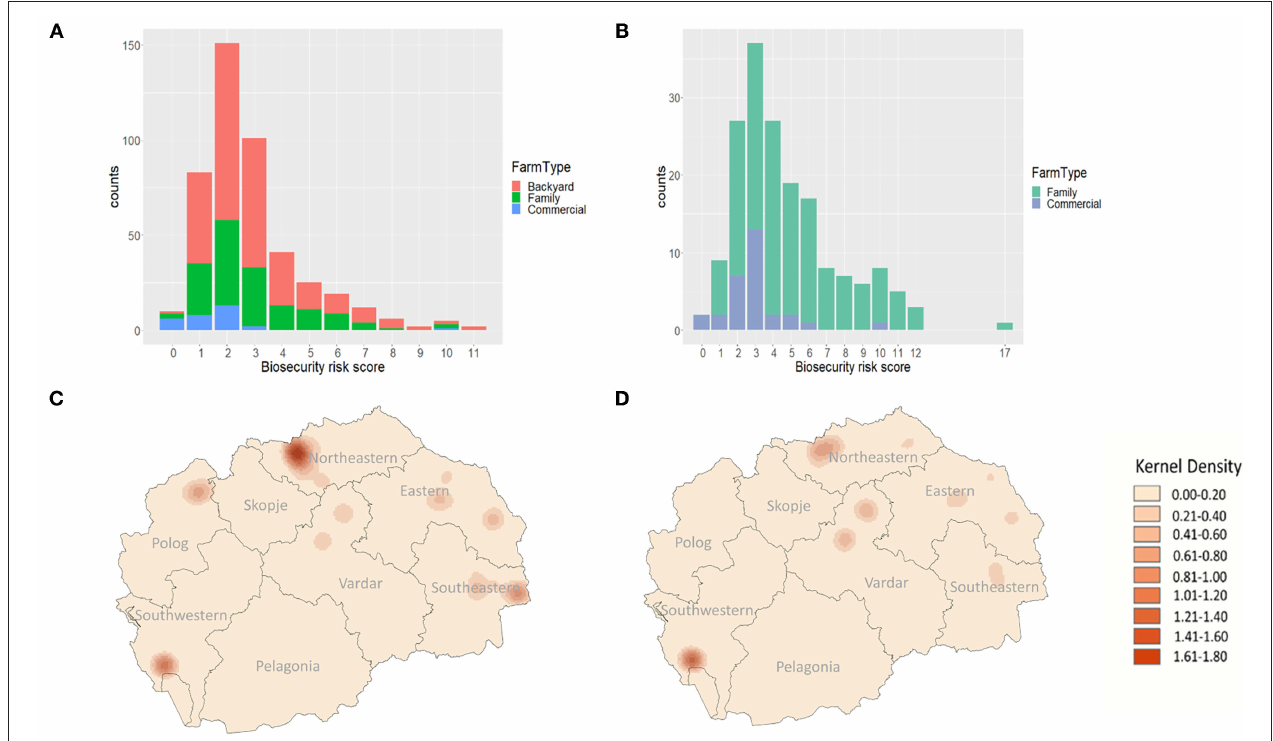
FIGURE 6 | Biosecurity risk scores for (A) all pig farms, and (B) family and commercial pig farms, administered questionnaires in North Macedonia between September 2019 and March 2020. Biosecurity risk scores represent a non-weighted linear combination of values assigned to dichotomized survey questions in which higher scores representing higher risk. Kernel density estimation (KDE) mapping of biosecurity risk scores for (C) all pig farms, and (D) family and commercial pig farms administered questionnaires in North Macedonia between September 2019 and March